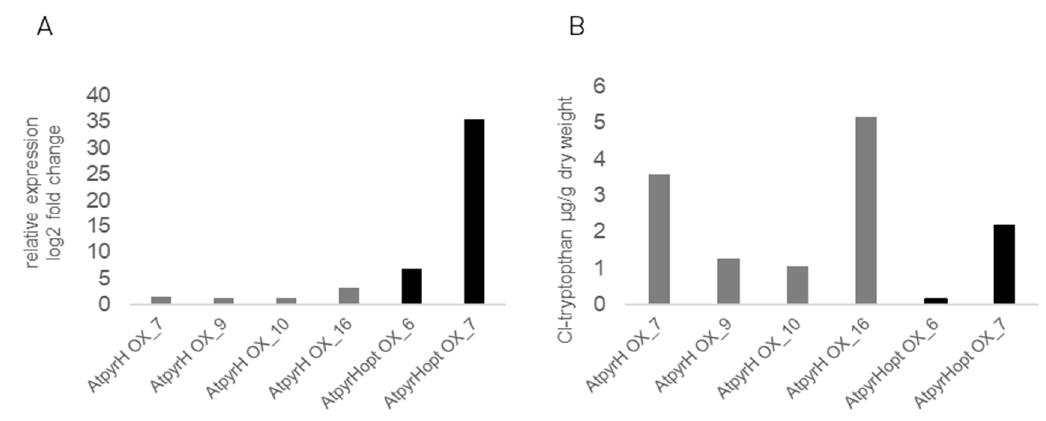
Figure 4. A : Analysis of relative gene expression of the corresponding halogenase genes with qRT-PCR. The corresponding reference gene was AtYLS8 . The normalization was done with the transgenic line with the lowest expression level (expression = 1). B : Concentration of chlorinated Trp in transgenic Arabidopsis thaliana lines is given in µ g / g dry weight. The x-axis describes the individual line names as given in the Materials and Methods Section. For each halogenase gene two optimized (black bars) and four original (grey bars) codon lines were analyzed.